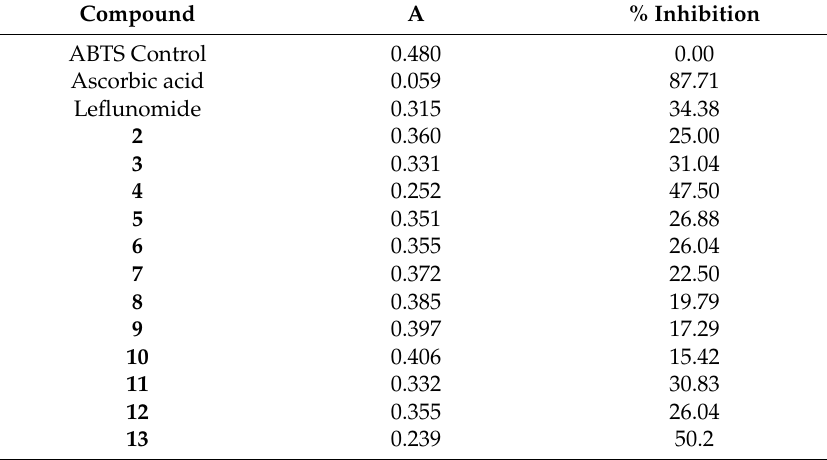
Table 4. Results of the preliminary qualitative antioxidant